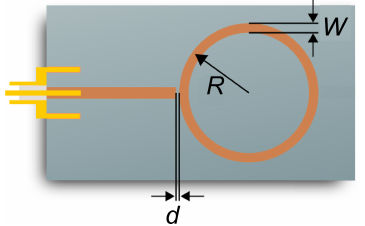
Figure 1. The geometry of the resonance structure.